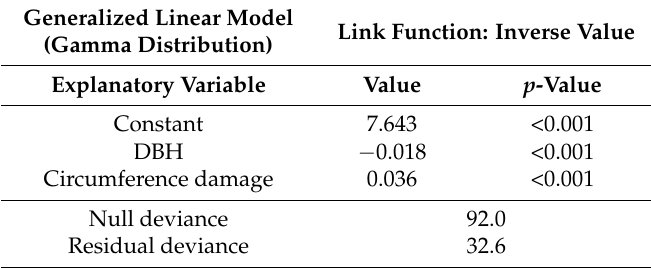
Table 4. Results of used generalized linear model. Provided p -values were related to the null hypotheses with the respective parameter equal to